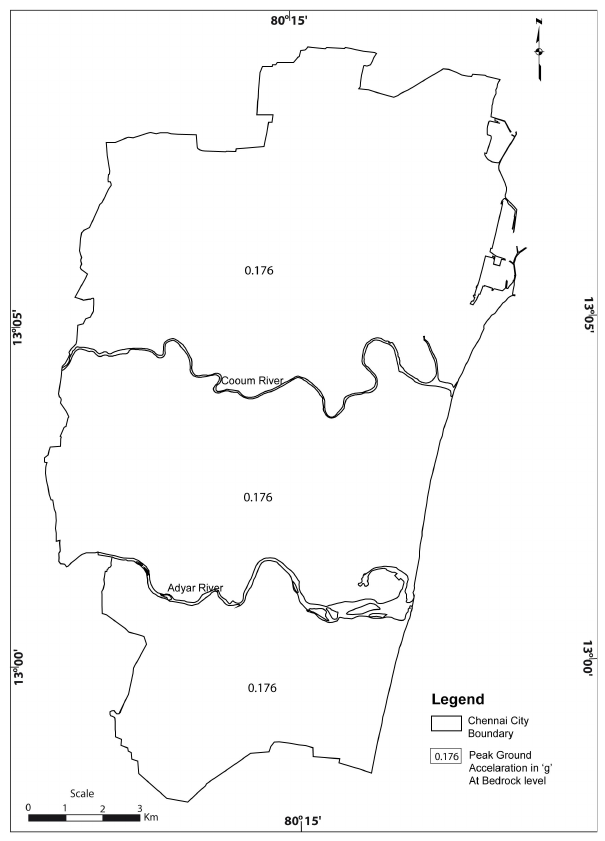
Fig. 2. Estimated peak ground acceleration for Chennai city.